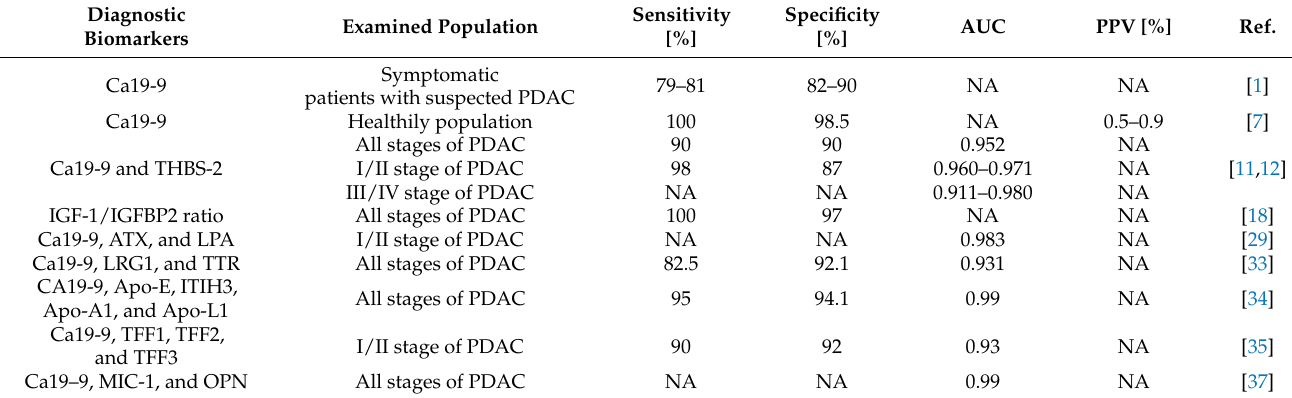
Table 1. Biomarkers used for the early diagnosis of PDAC